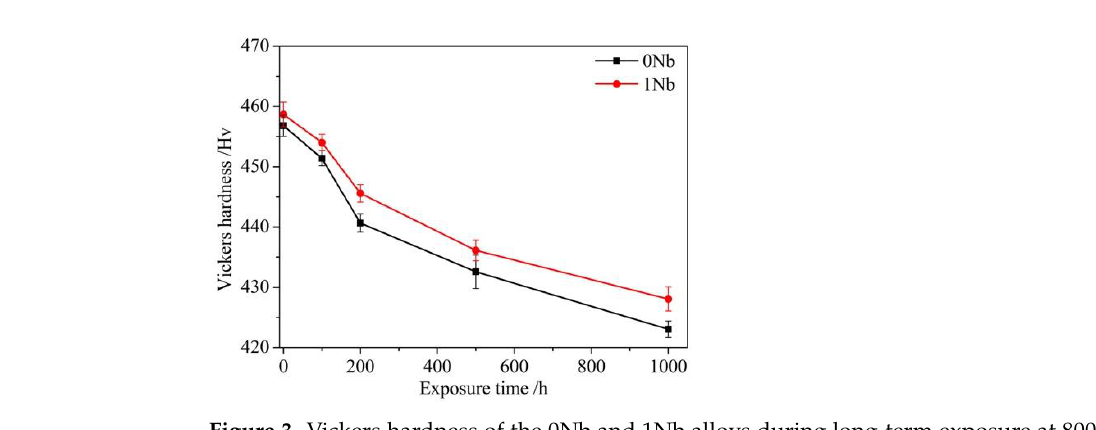
Figure 3. Vickers hardness of the 0Nb and 1Nb alloys during long-term exposure at 800 °C up to 1000 h.